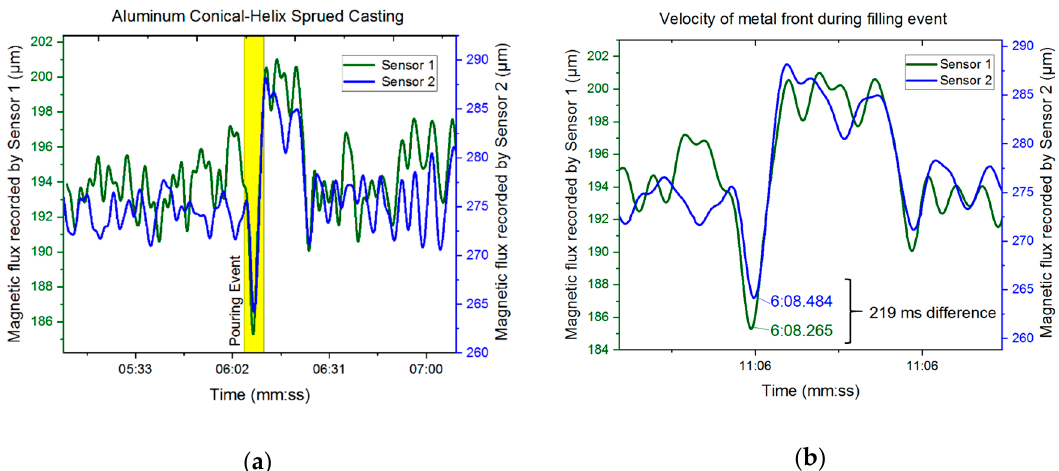
Figure 11. Magnetic flux by both the magnetometers at the particular event of: ( a ) filling and ( b ) two time data points that are the instants of metal recognition by the sensors: ( a ) magnetic field data for two minutes of the pour, and ( b ) data during melt travel across sensors 1 and 2 across the runner.